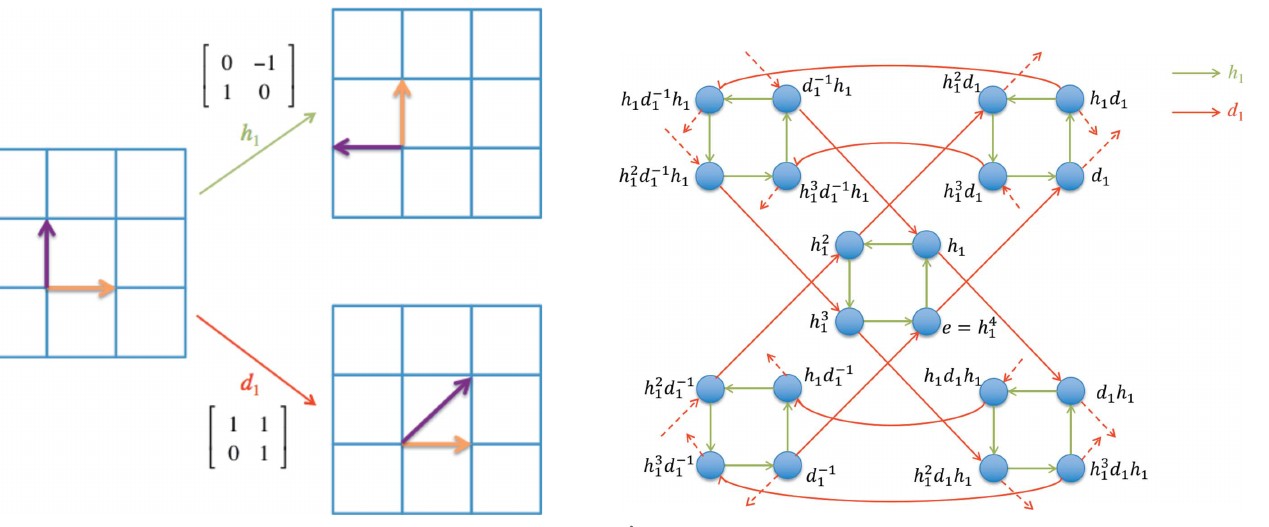
Figure 1 A geometric illustration of the crystal symmetry operation ( h 1 ) and the lattice-invariant deformation operation ( d 1 ) of a square lattice in 2D.